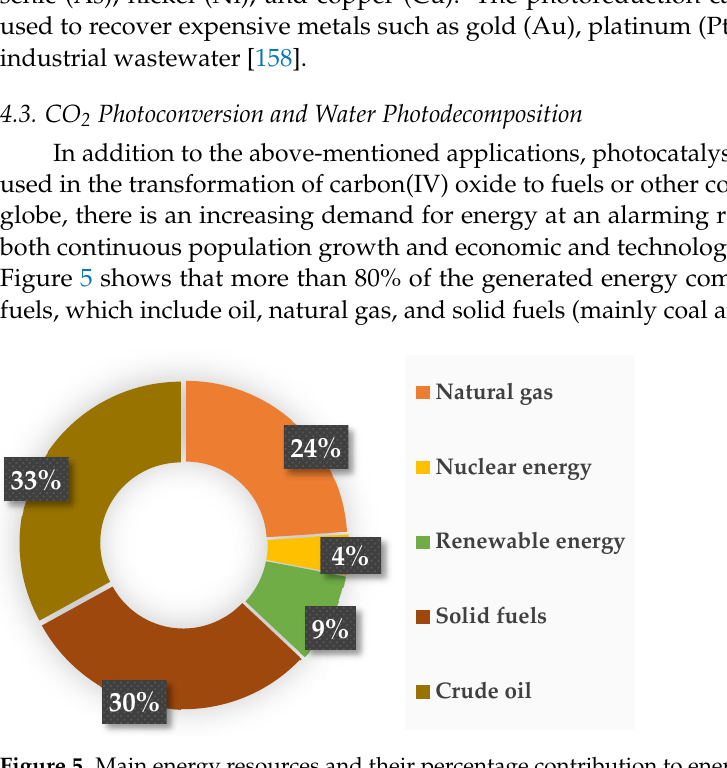
Figure 5. Main energy resources and their percentage contribution to energy production [161].